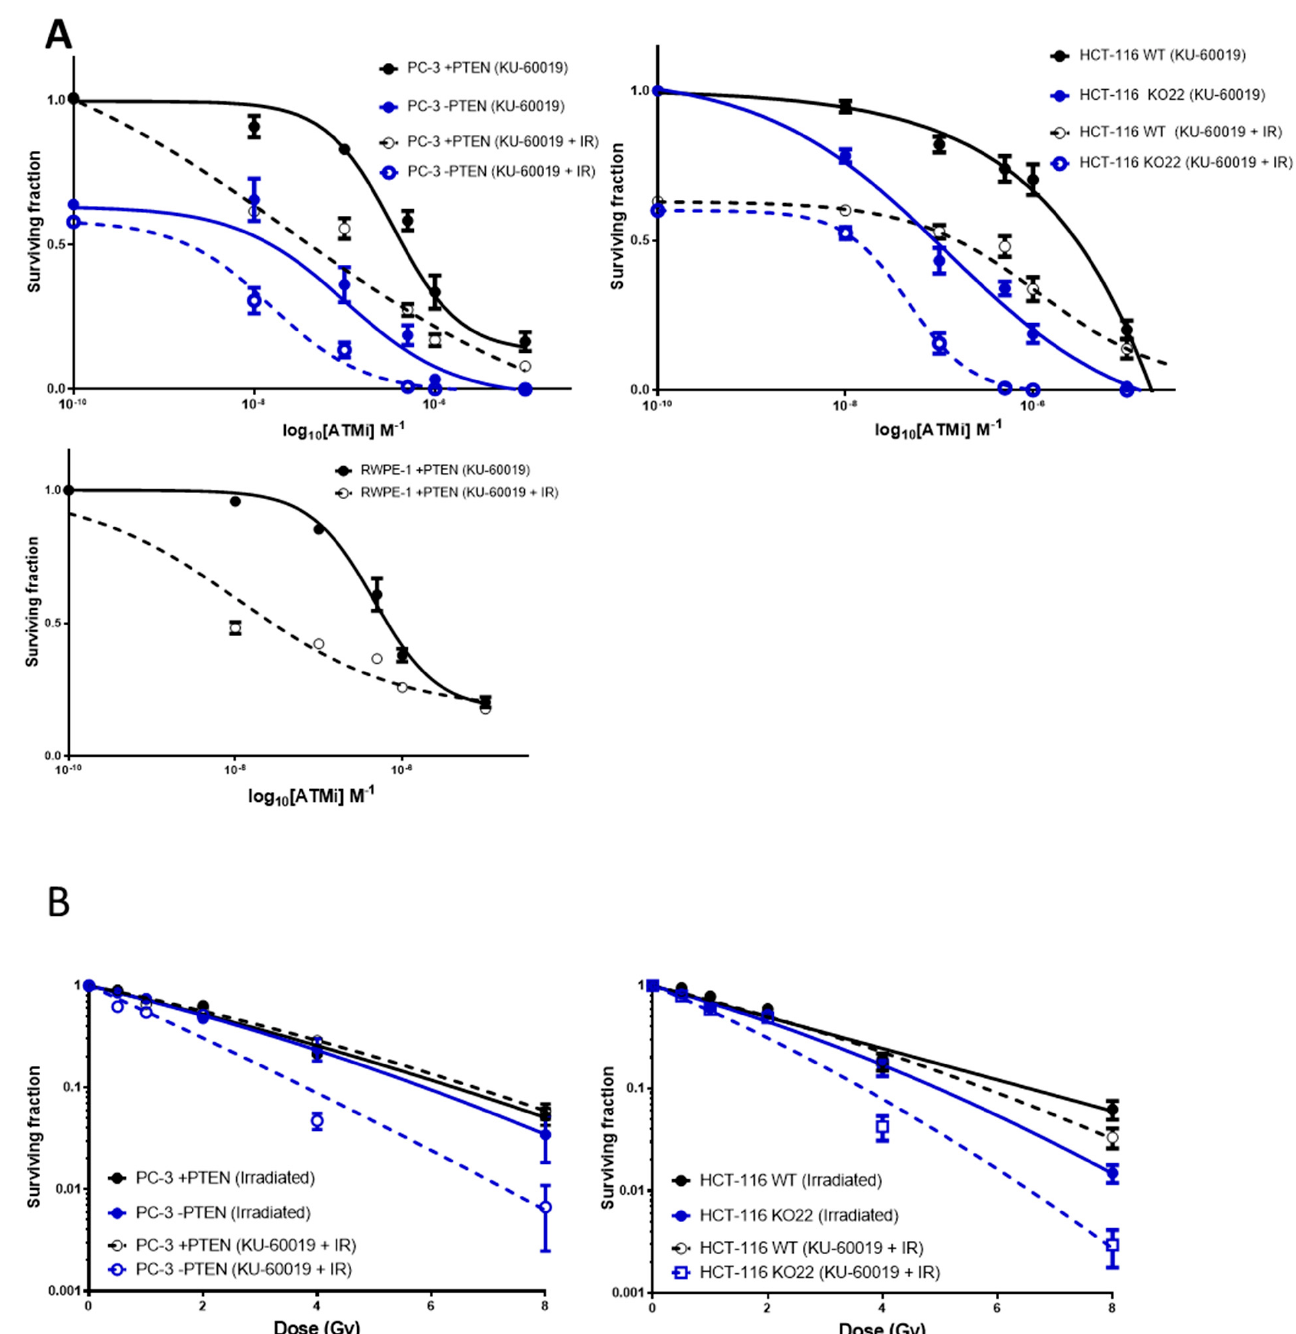
Figure 2. Impact of PTEN status on the survival response to combinations with radiation and KU-60019. ( A ) Dose response curves PC-3 and HCT-116 PTEN isogenic and RWPE-1 normal prostate cell models following treatment with KU-60019 alone ( ● , ■ ) or in combination with radiation ( ○ , □ ). In the combined treatment groups, cells received 2 Gy ionising radia- tion, 1 h immediately following KU-60019 treatment. ( B ) Clonogenic survival curves of PC-3 and HCT-116 PTEN isogenic cell models following radiation ( ● , ■ ) or combined KU-60019 [LC 50 PTEN deficient cells] + radiation treatment ( ○ , □ ). LC 50